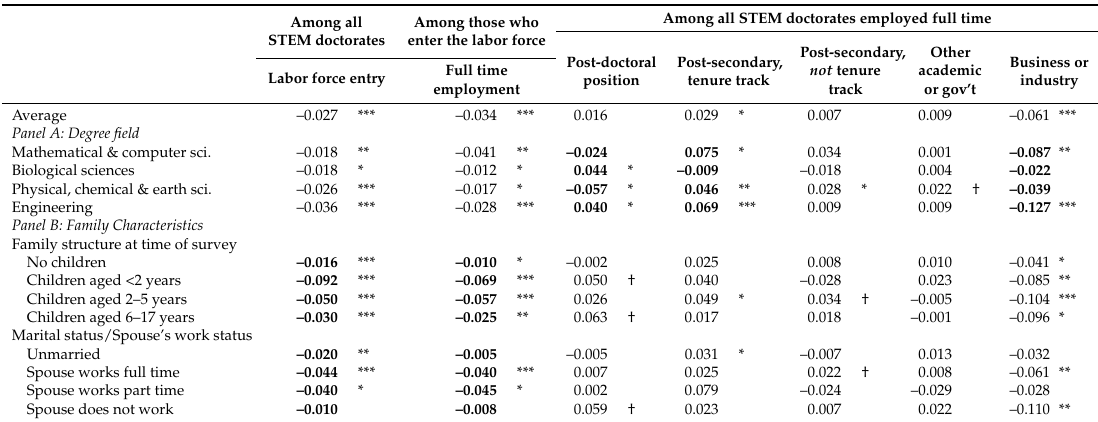
Table 2. Estimated marginal effect of FEMALE on labor force entry, full-time employment, and employment sector, by degree field and family